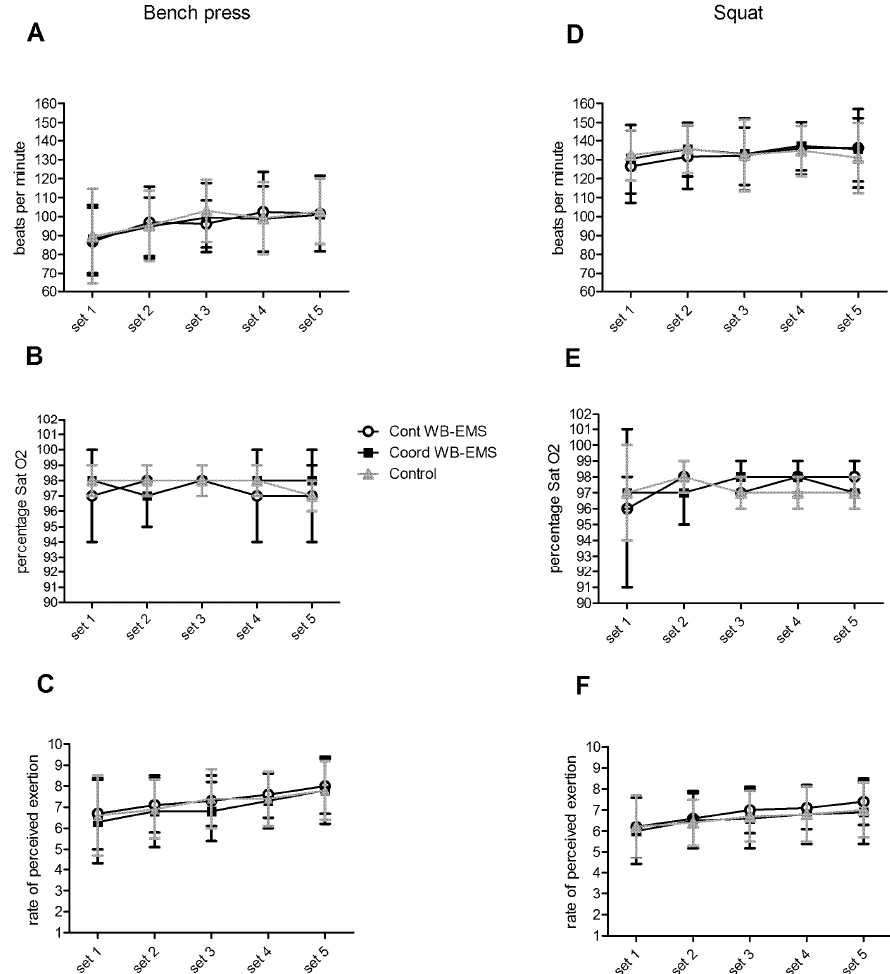
Figure 2. ( A ): heart rate, ( B ): percentage of the oxygen saturation, and ( C ): rate of the perceived exertion during the bench press exercise with the continuous stimulus (Cont WB-EM), coordinated stimulus with concentric and eccentric phases (Coord WB-EMS) and without whole-body electromyostimulation (Control). ( D ): heart rate, ( E ): percentage of the oxygen saturation, and ( F ): rate of the perceived exertion during the squat exercise with the continuous stimulus (Cont WB-EM), the coordinated stimulus with concentric and eccentric phases (Coord WB-EMS) and without whole-body electromyostimulation (Control).